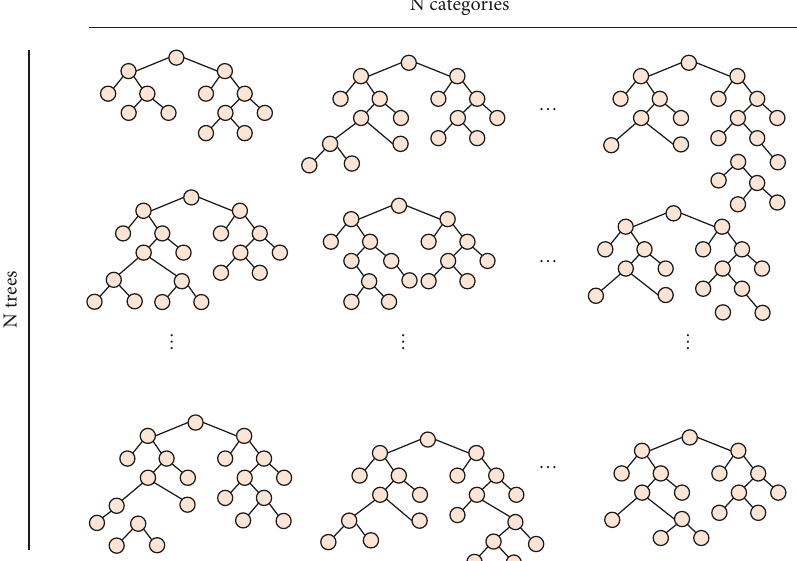
Figure 3: Structure diagram of the XGBoost model.